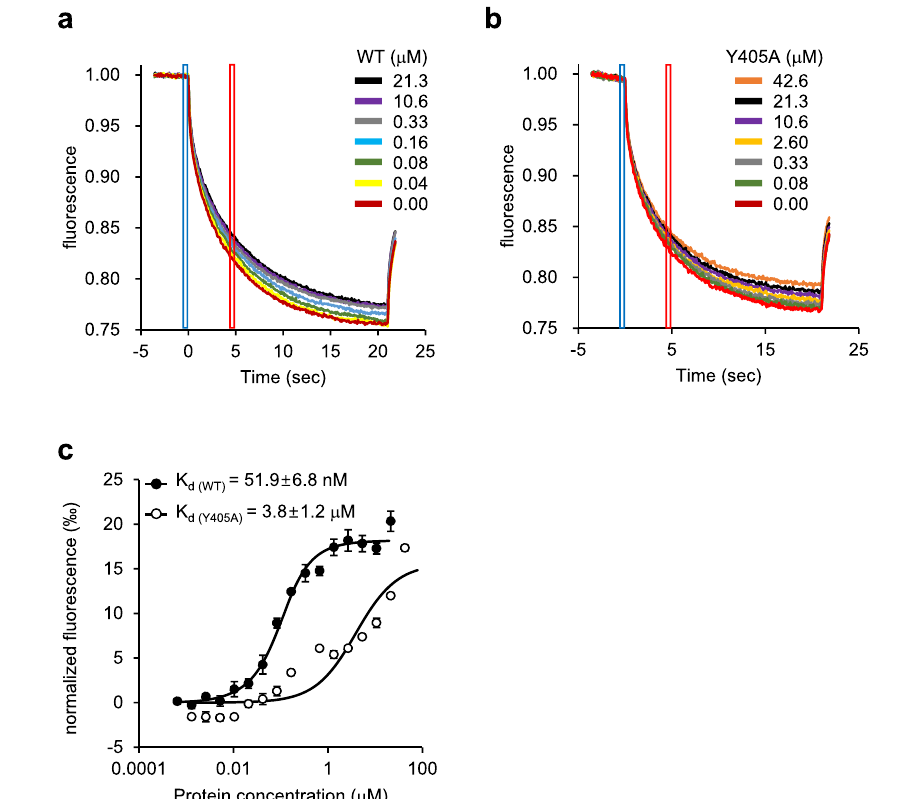
Fig. 5 | Thermophoretic analysis of the Δ TMD0 – peptide interaction. a and b Microscale thermophoresis (MST) pro fi les of a the Δ TMD0- and b the Y405A- peptide (RRYQNSTC Cy-5 L) interaction. F cold (blue region) at 0s represents the cooled state, and F hot (red region) at 5s represents the heated state during ther- mophoresis. c Normalized fl uorescence changes were measured to yield binding